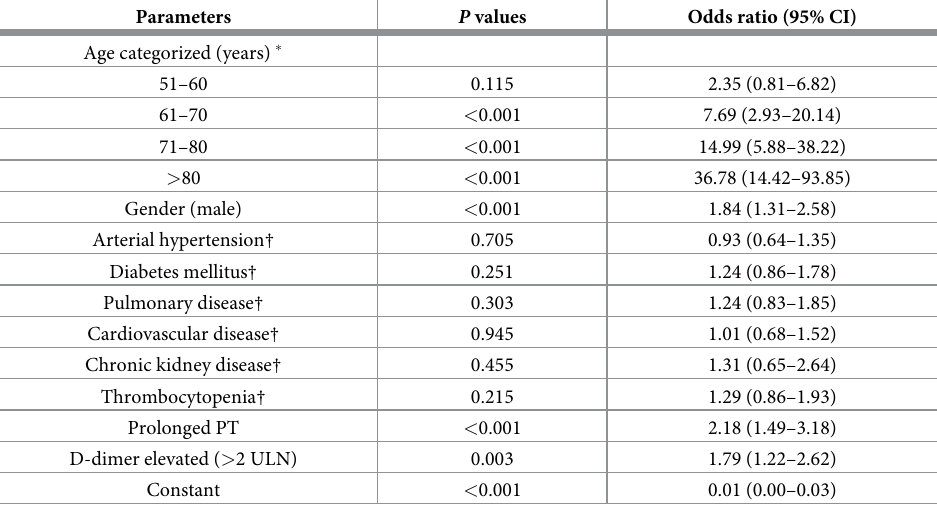
Table 2. Multivariate